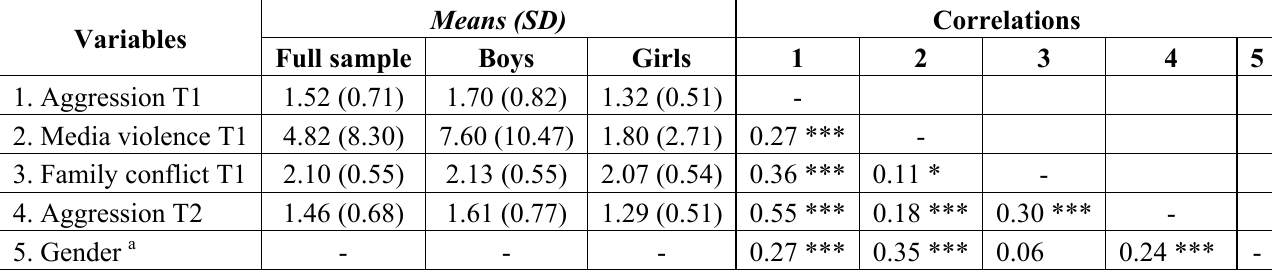
Table 1. Means (standard deviations) and correlations for model variables.